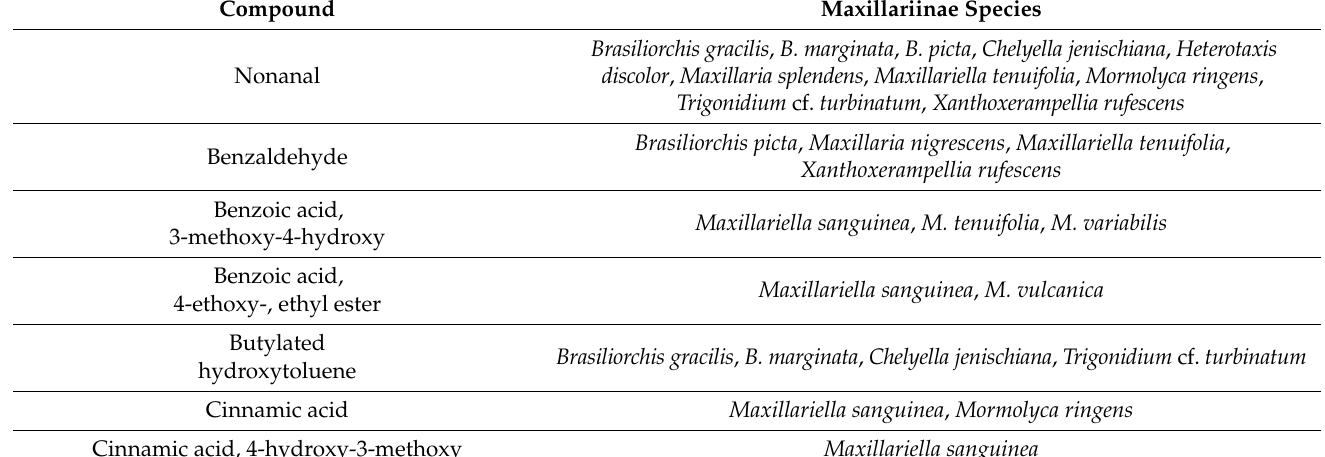
Table 1. List of the active compounds detected in Maxillariinae